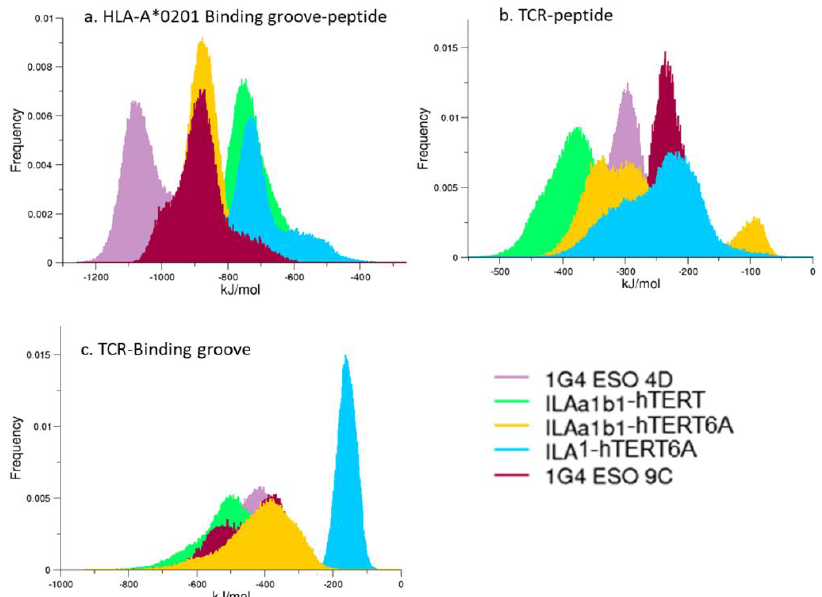
Figure 8. Interaction Energies. The distribution of the energy profiles of the complexes is reported. Panel ( a ): the interaction energy between the binding groove and the peptide; panel ( b ): the interaction energy between the TCR and the peptide; panel ( c ): the interaction energy between the TCR and the binding groove.